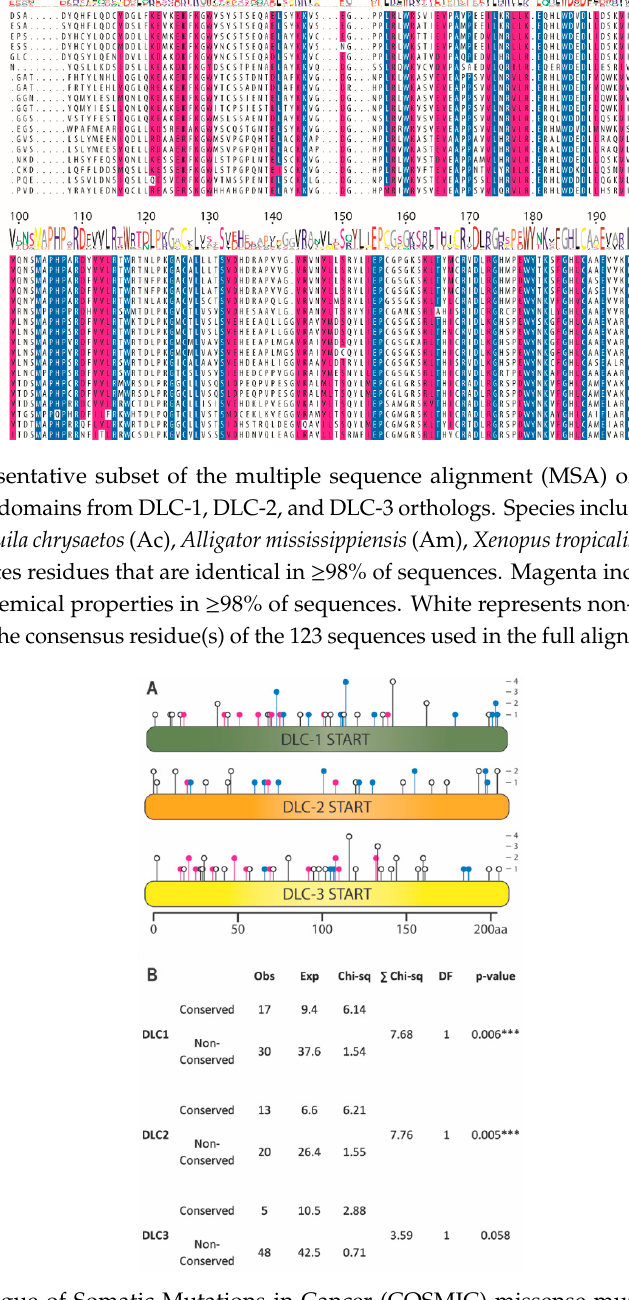
Figure 3. Catalogue of Somatic Mutations in Cancer (COSMIC) missense mutations localizing to conserved residues of DLC-1, DLC-2, and DLC-3 START domains. ( A ) Lollipop plot displaying the location and frequency of missense mutations. Mutations occur in identically conserved (blue), physiochemically conserved (magenta), or non-conserved residues (white). ( B ) COSMIC missense mutations are overrepresented in the evolutionarily-conserved residues of the START domains of DLC-1 and DLC-2 but not DLC-3. Content is identical to Table S7. *** p < 0.001, chi-square